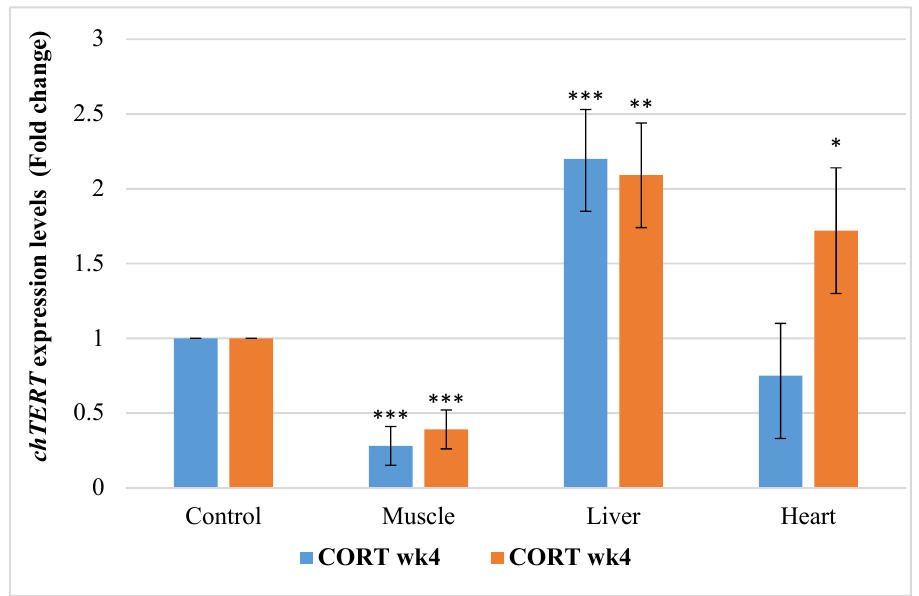
Figure 2. Expression profile of chicken telomerase ( chTERT ) in the muscle, liver, and heart at week 4 and 6 of age in CORT-fed chickens compared to the control. CORT wk4 = 4 weeks of age (2 weeks of CORT administration); CORT wk6 = 6 weeks of age (4 weeks of CORT administration); n = 20. Probability, * = p < 0.05; ** = p < 0.01; *** = p < 0.001.